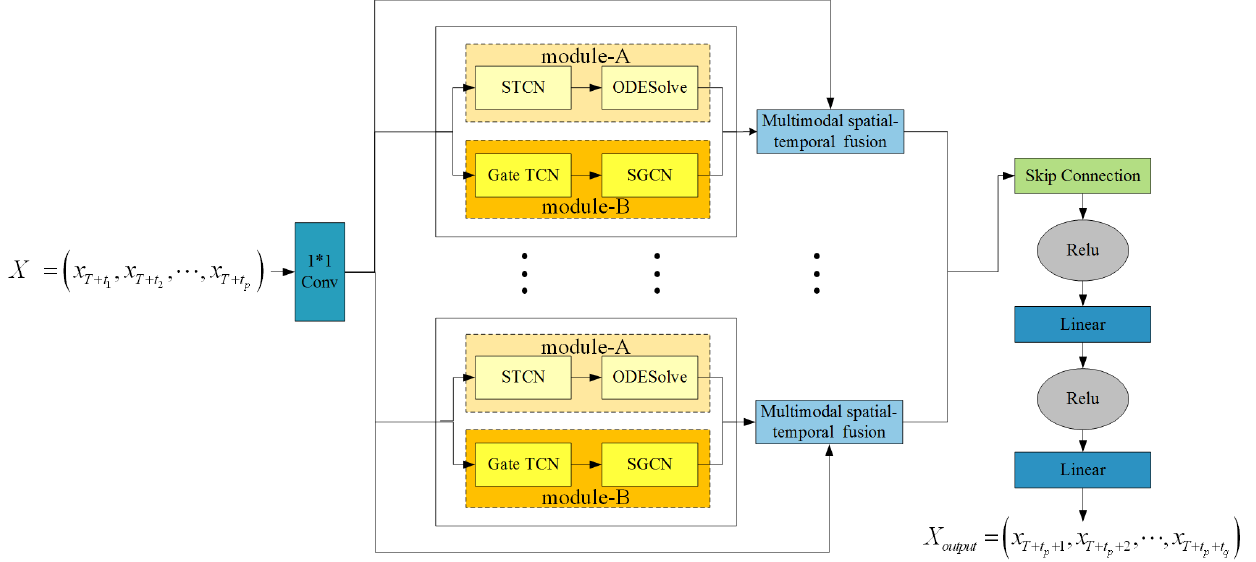
Figure 2. General framework. It consists of K spatial-temporal layers and the output layer on the